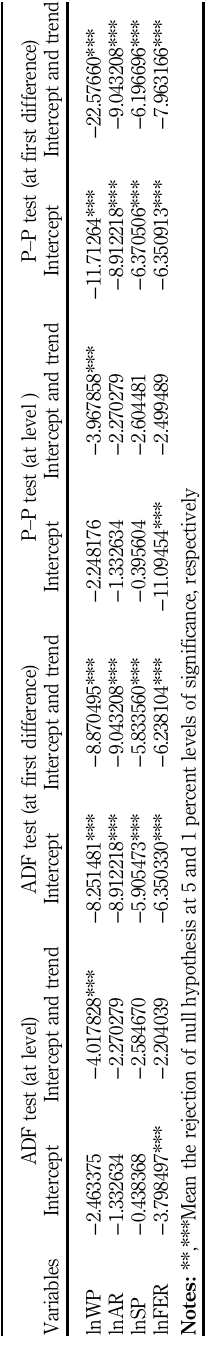
Table II. Results of